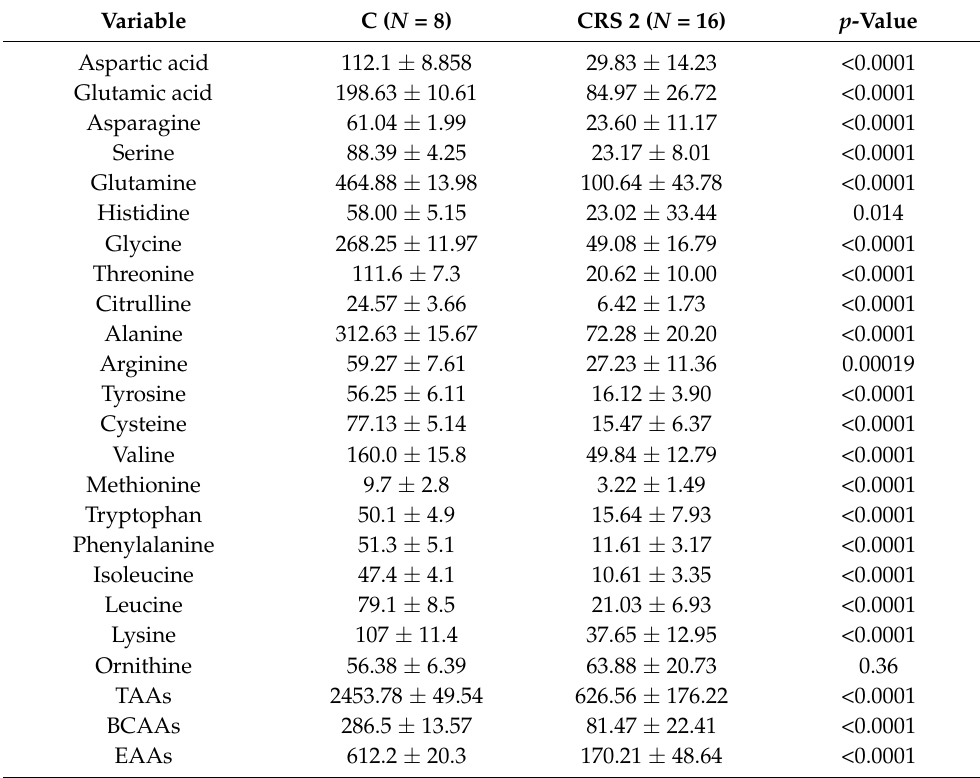
Table 2. Plasma arterial AA concentrations ( µ mol/L) in controls (C) and cardiorenal syndrome type 2 (CRS 2)